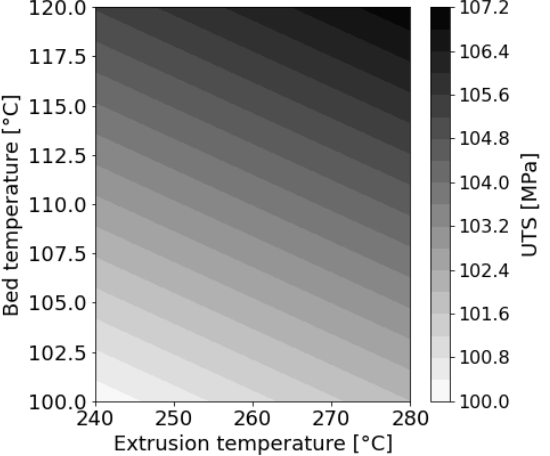
Figure A2. Contour plot for T ext and h based on DoE prediction model.